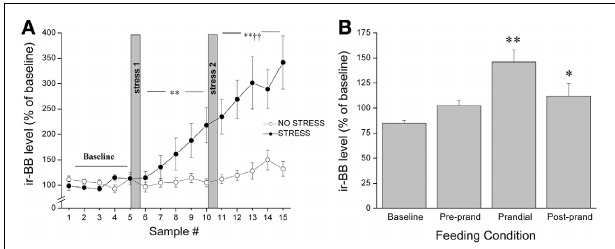
FIGURE 2 | Release of BBs at the CeA as measured by in vivo microdialysis in response to (A) restraint stress exposure (20min hand restraint on two separate occasions called stress 1 and stress 2) or (B) presentation and ingestion of a palatable snack where microdialysis samples were collected continually and pooled every 30min for 5h. The quantity of food ingested during the 30min bin was noted and the 30min period before meal initiation was considered the preprandial period, and the 30min sample preceding this was considered the baseline. Both stressor exposure and ingestion of a palatable snack elicited a significant increase in the release of BBs (and CRF) at the CeA accompanied by a parallel increase in plasma corticosterone levels. ∗ , ∗∗ Significantly different from baseline at p < 0 . 05 and p < 0 . 01, respectively. †† Significantly different from stress 1 at p < 0 .